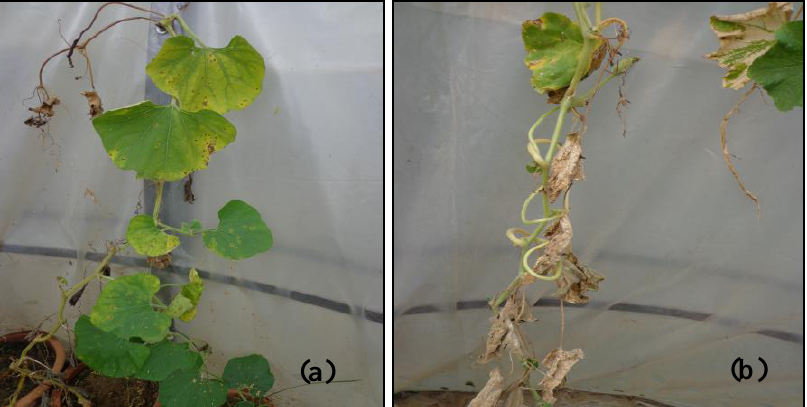
Figure 6. Gas injury caused by SO 2 exposure in inoculated plants at ( a ) 50 ppb and ( b ) 75 ppb.